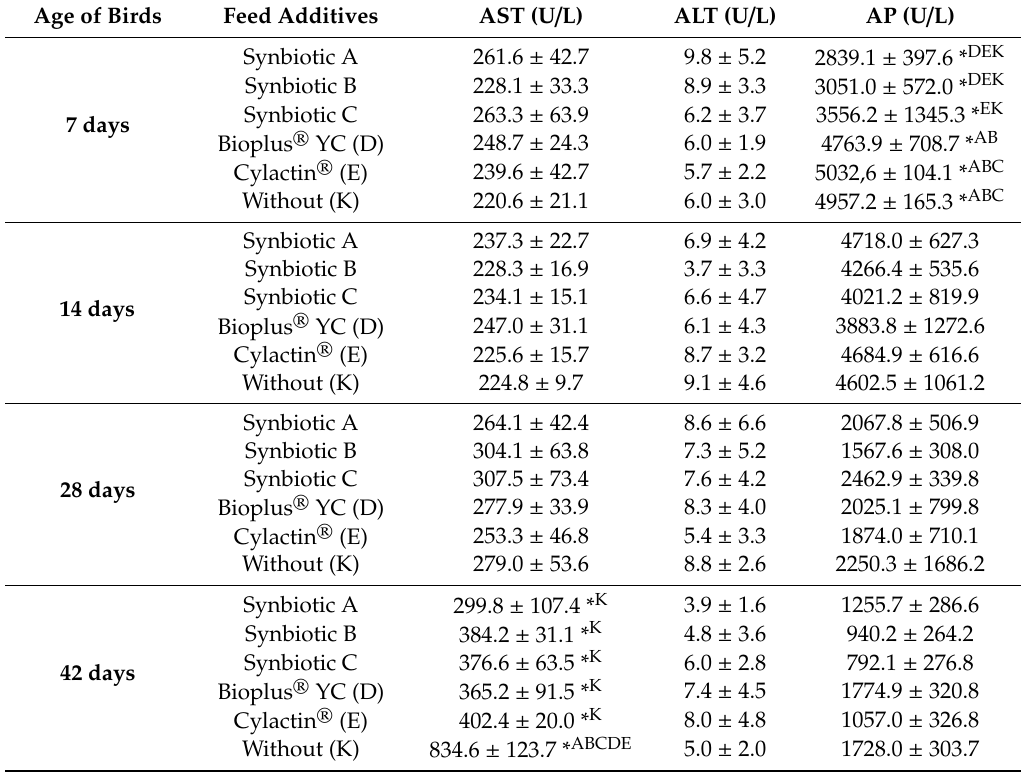
Table 4. Activity of the tested enzymes (aspartate transaminase (AST), alanine transaminase (ALT), alkaline phosphatase (AP) in the blood serum of the experimental chickens. *—statistically significant di ff erences between groups, p ≤